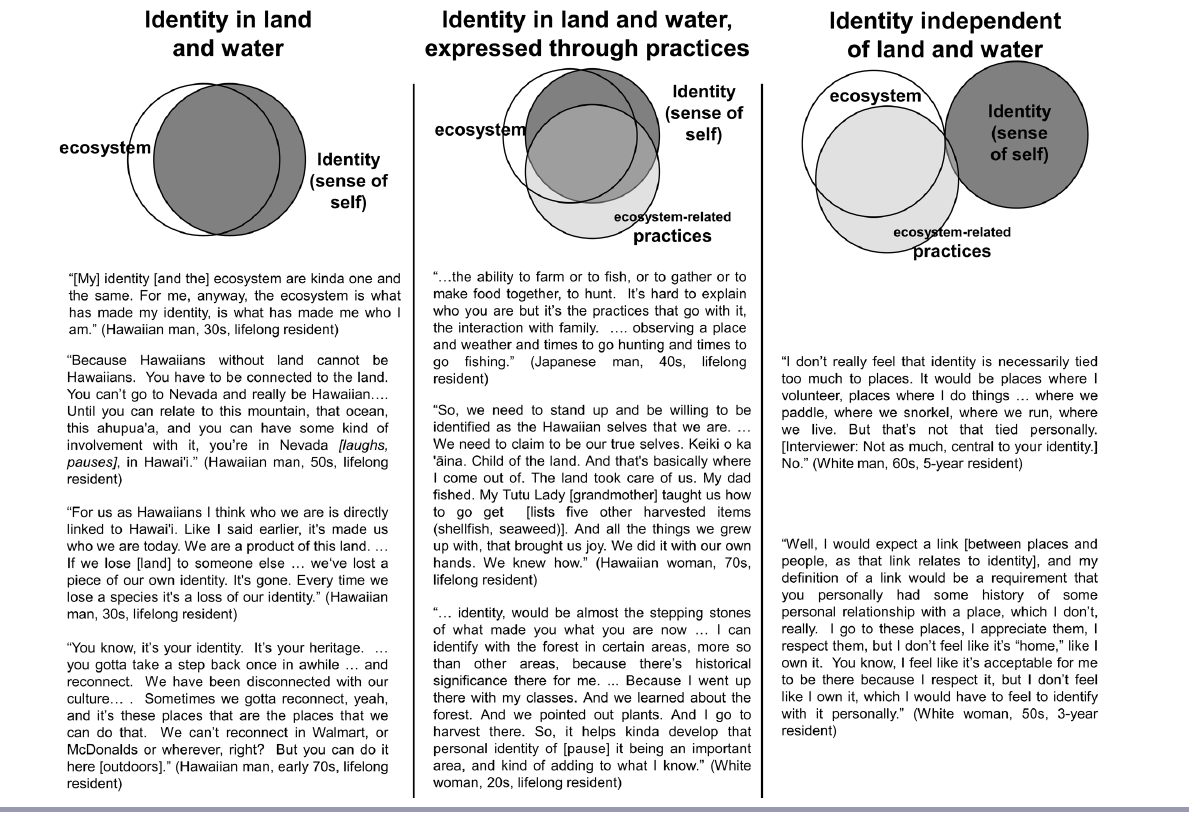
Fig. 4 . Identity-ecosystem relationships, as discussed by interview respondents.